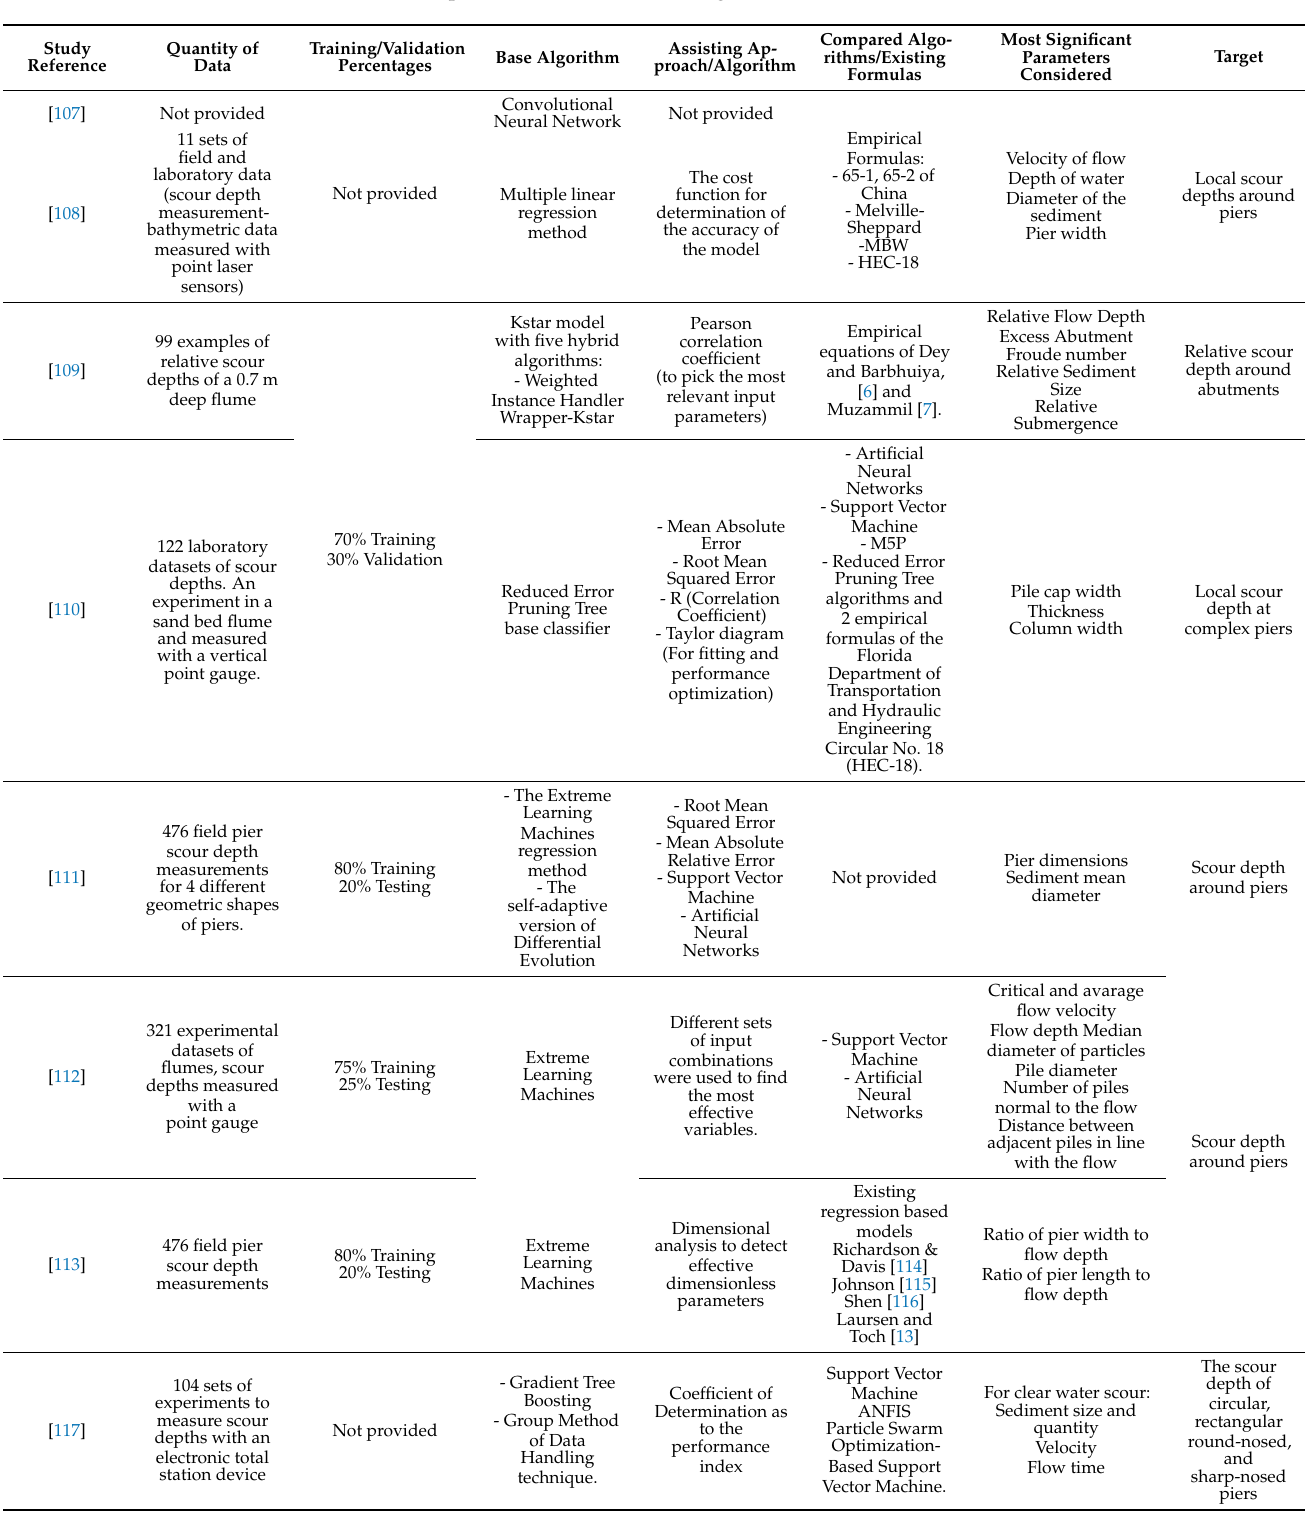
Table 3. Properties of Machine Learning studies—Cluster